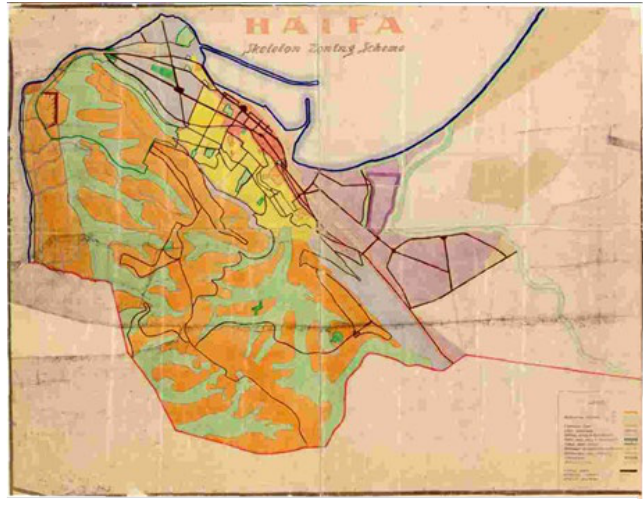
Figure 2 Haifa Plan 229, 1934. Source: the Haifa City Archive